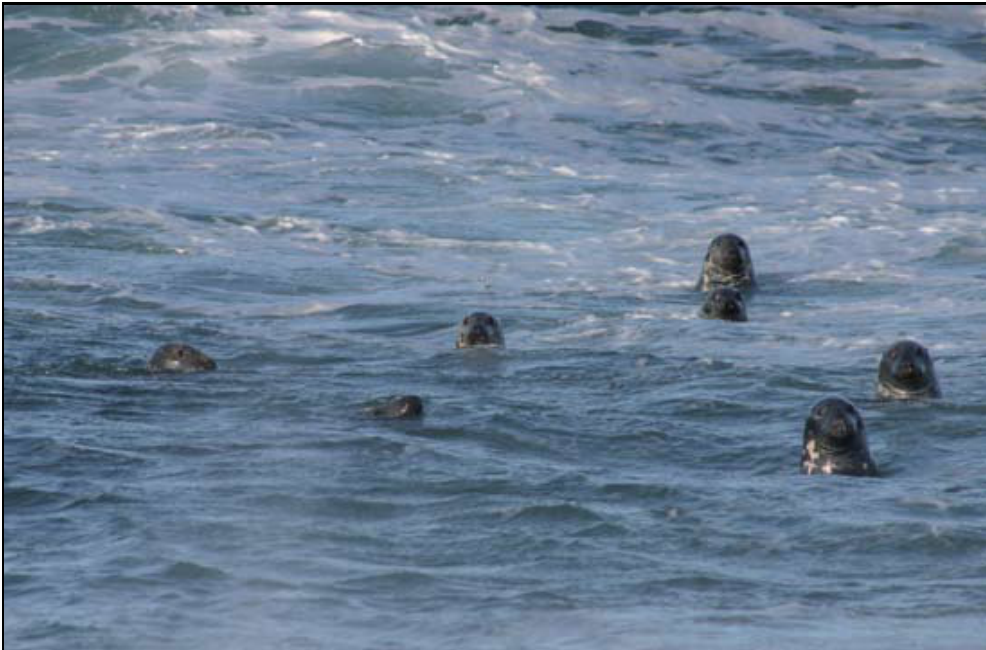
Fig. 1. Grey seals off Sable Island, Canada. (Photo: